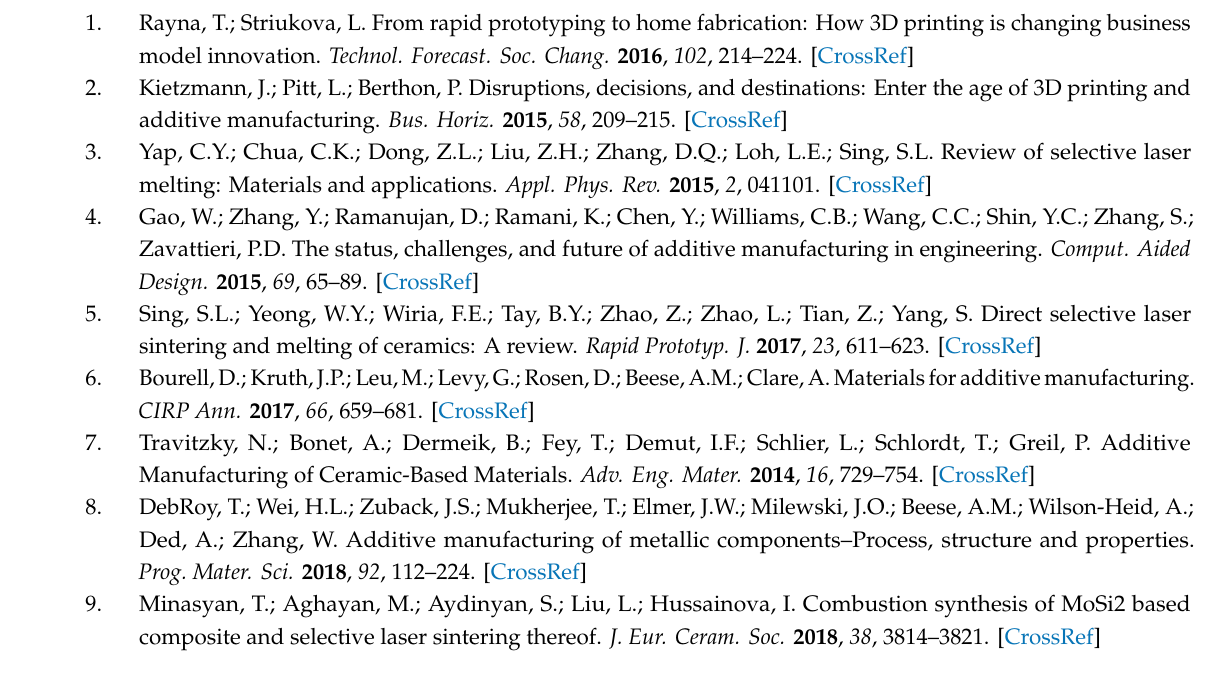
Figure S1: Arrhenius plot for the e ff ective activation energy of the Ti-B-Si combustion